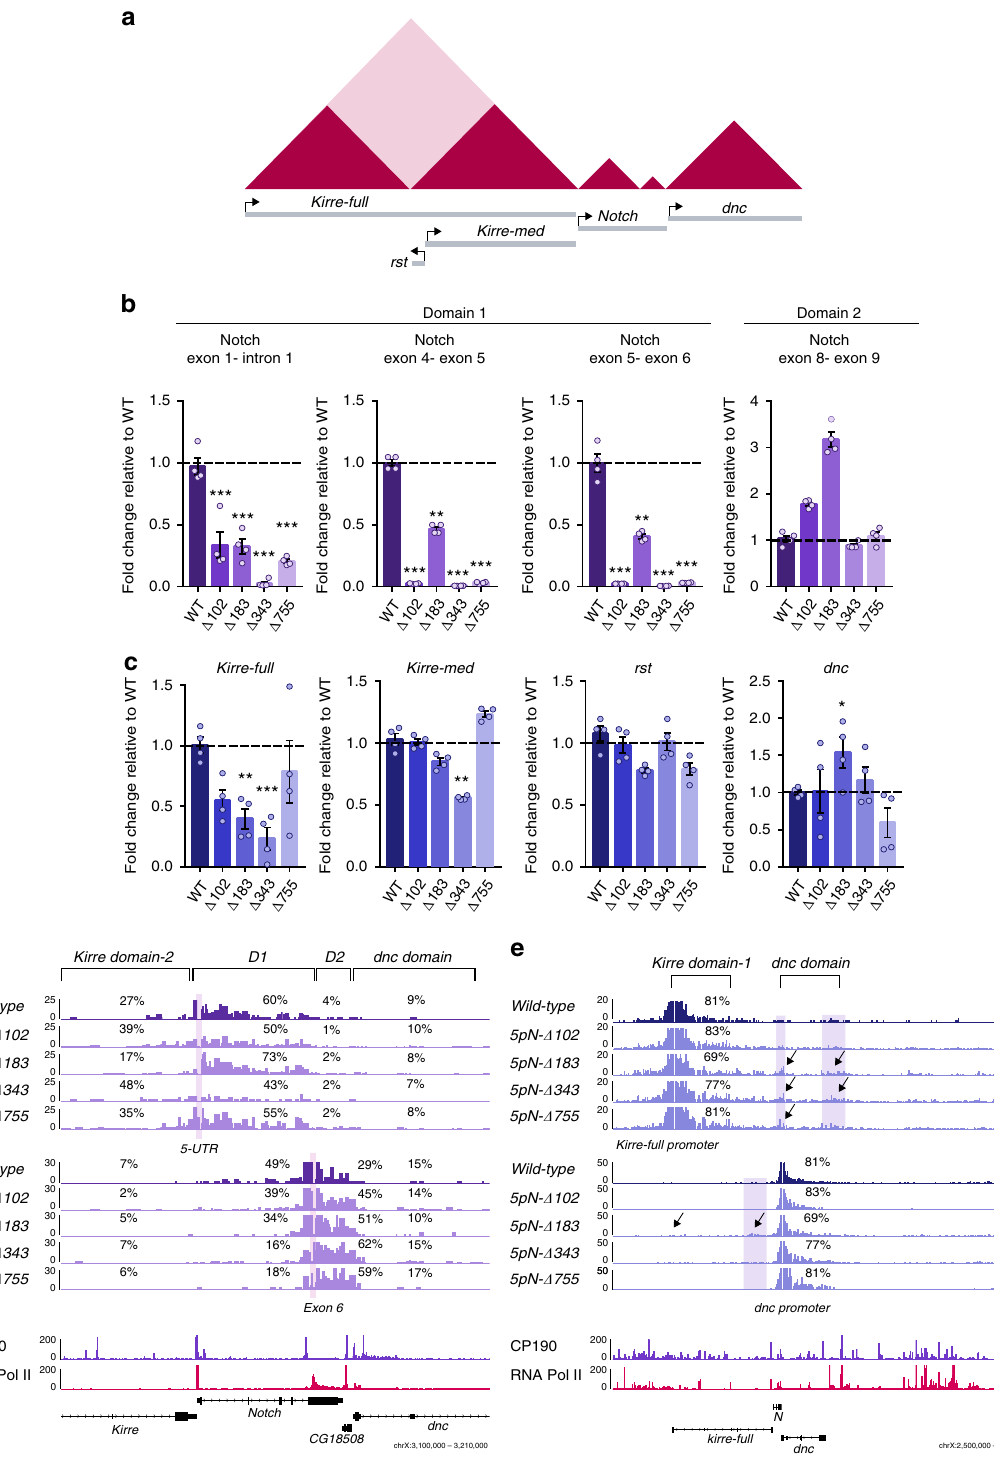
contains the major TSSs of Notch , with kirre domain-2 (Fig.